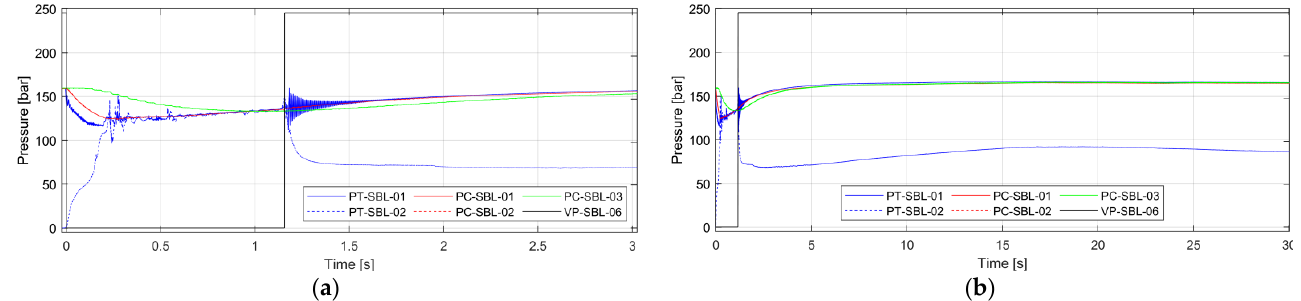
Figure 9. Pressure time trends in SBL injection line and valve position. ( a ) zoom on [0–3] s, ( b ) zoom on [0–30] s.